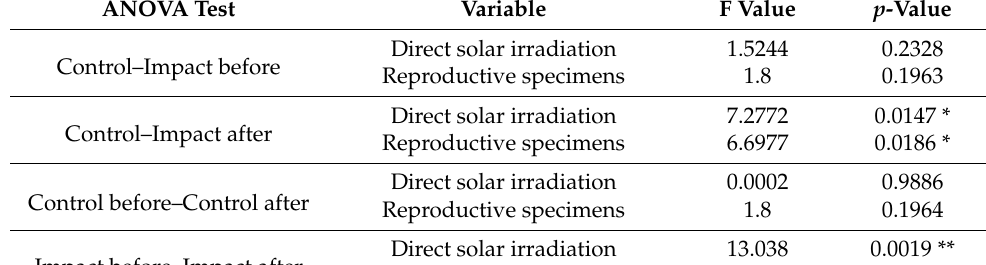
Table 2. ANOVA test results of the BACI analysis. Significance codes: * < 0.05, ** < 0.01.